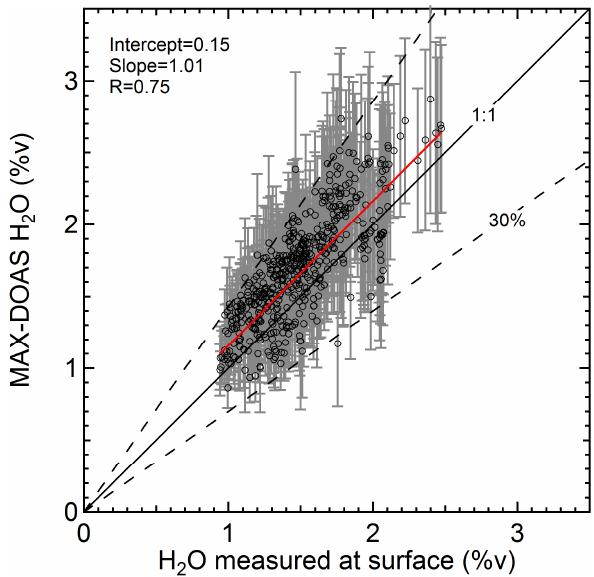
Fig. 10. MAX-DOAS-CHIMERE correlations for (a) HCHO and (b) CHOCHO. Colors indicate the ambient temperature. For each plot, the linear least-squares fit taking into account error ranges of MAX-DOAS data is shown with a red line. The correlation coefficient R is given. Note that steps in CHIMERE CHOCHO values have occurred due to output at limited numerical resolution.